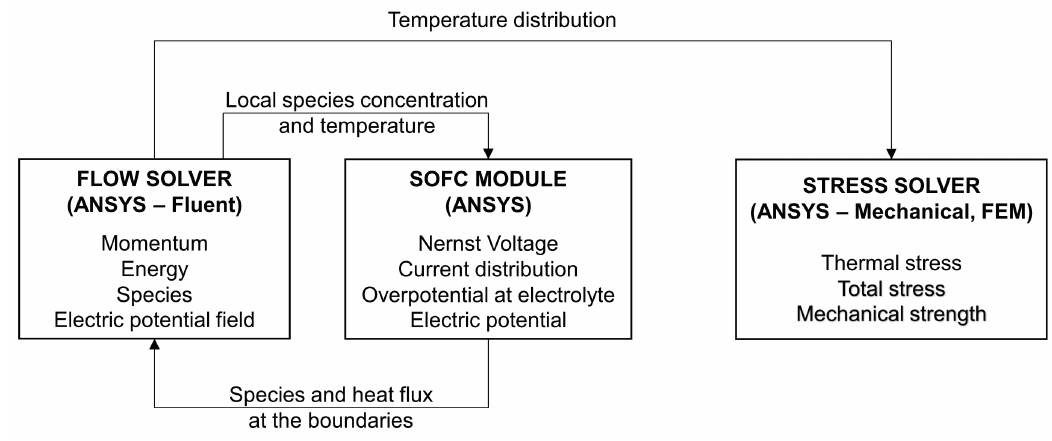
Figure 1: Coupling of the thermal-fluid – flow solver and SOFC module with the stress